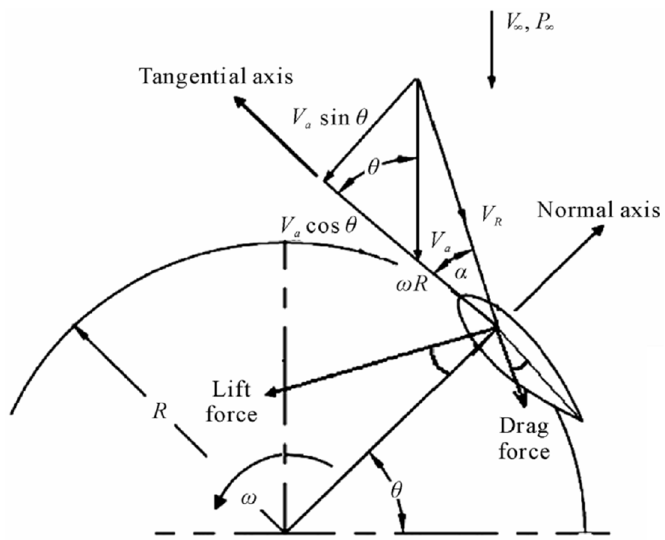
Figure 6. Airfoil velocity and force diagram, reprinted with permission from